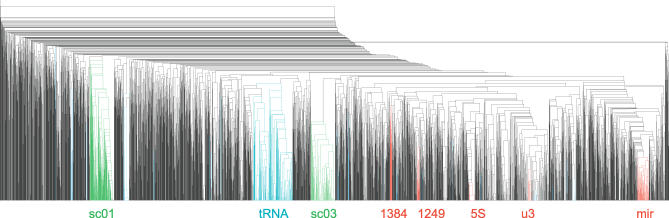
Summary of the Clustering ProcedureThe WPGMA tree contains 3,332 putative ncRNAs. A few large, prominent clusters are indicated. Among them are tRNAs and U3 snRNA, and an miRNA cluster, Figure 5, which contains the known miRNAs mir-124-a/b and let-7 as well as candidates for mir-126 and mir-7. Clusters 1384 in Figure 6 and 249 in Figure 7 are good candidates for novel ncRNA classes. sc01 and sc03 are both example clusters based on high sequence similarity.